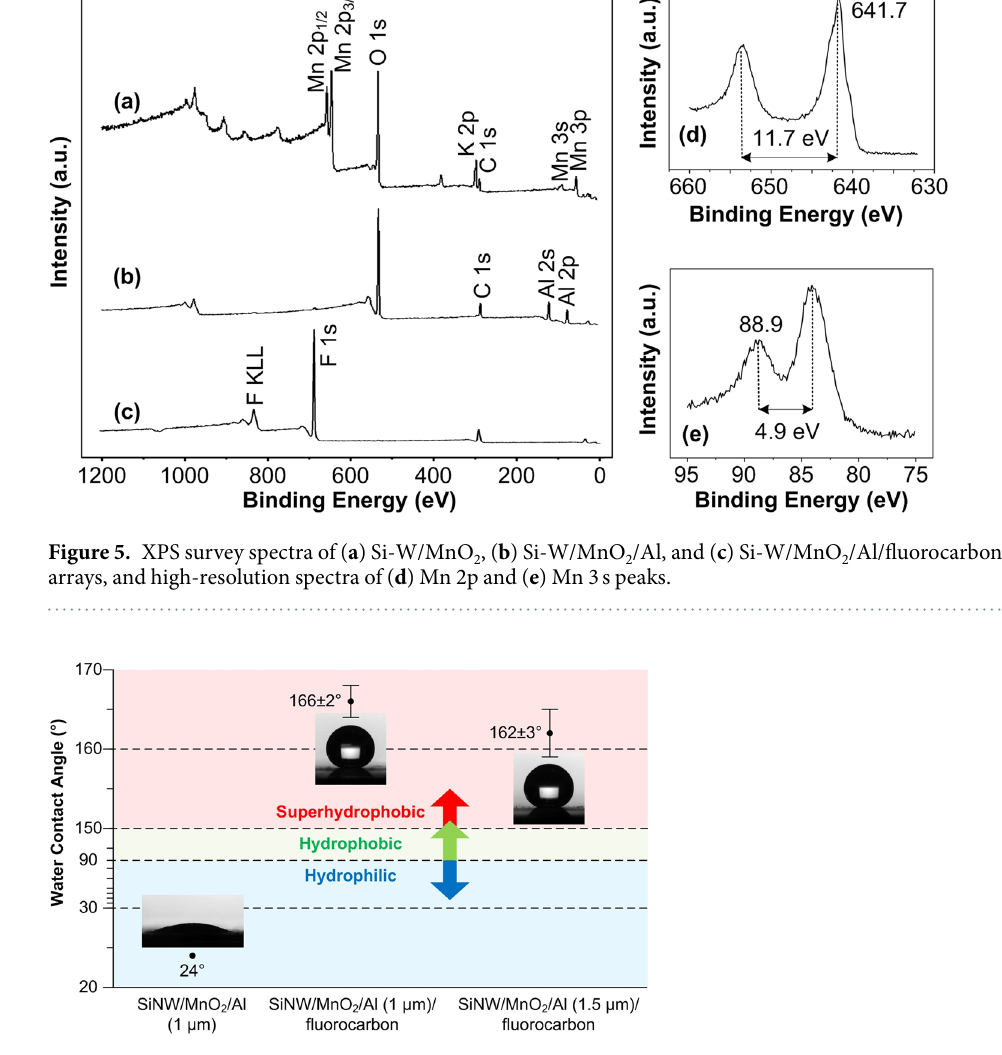
Figure 6. Water contact angles of different